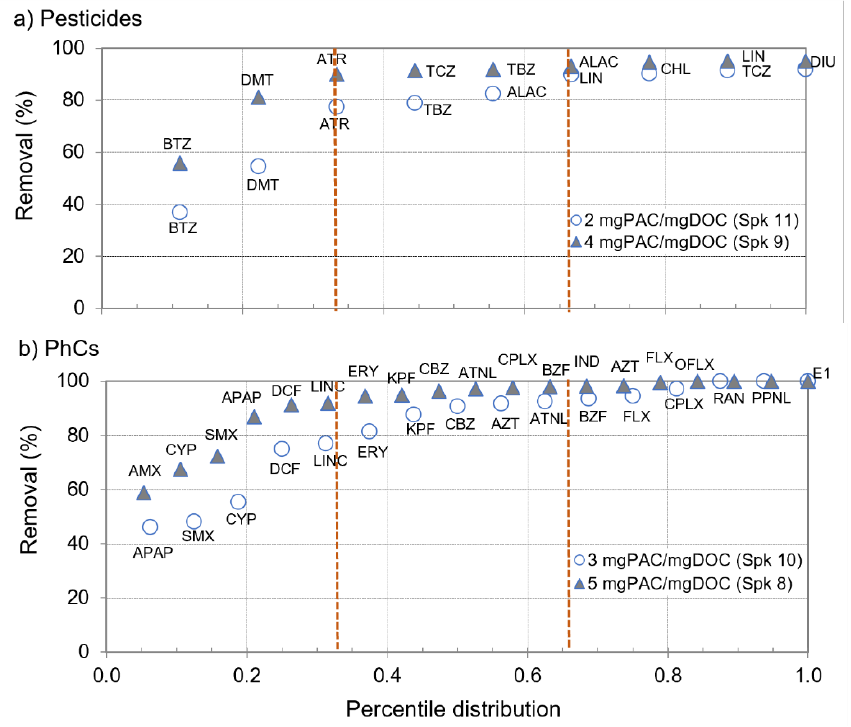
Figure 4. Percentile distribution of removal efficiencies of 9 pesticides ( a ) and 16–19 PhCs ( b ) during two spiking trials each (those with the highest number of microcontaminants and the lowest PAC doses).